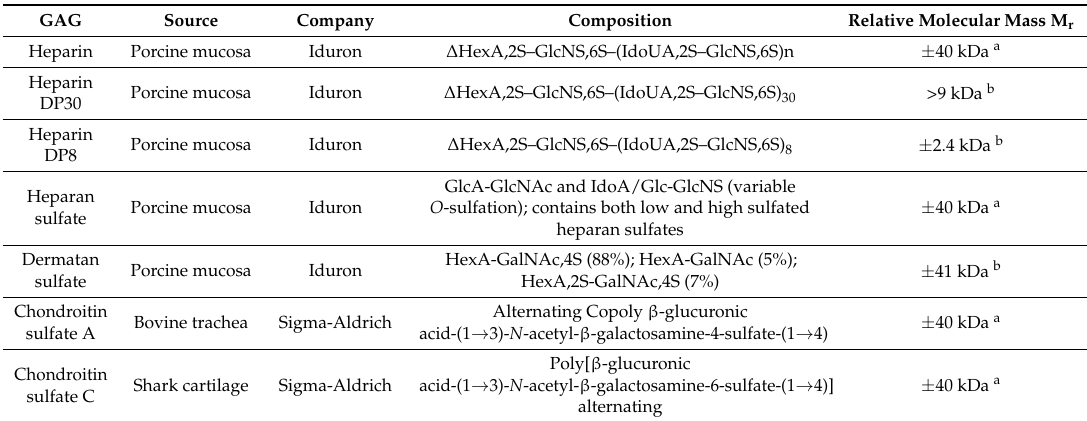
Table 2. Specifications of GAGs used in